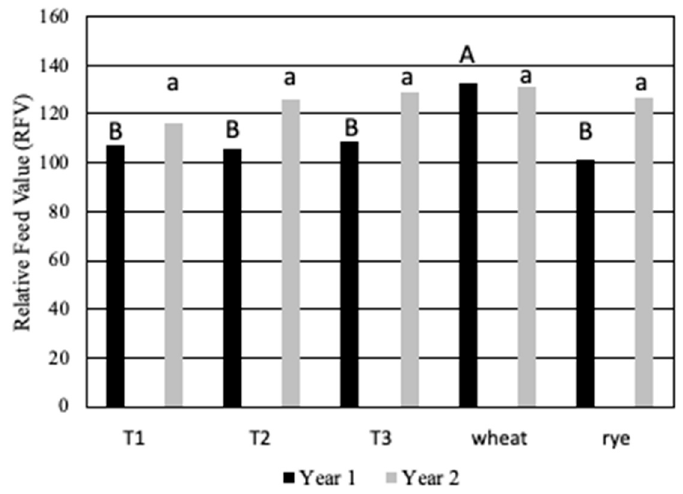
Figure 4. Relative feed values (RFVs) of DPCCs in each experimental year. Means separated by Tukey’s HSD range test. Within the same row, values followed by different letters are statistically different. Uppercase letters are associated with values in year 1; lowercase letters are associated with values in year 2.